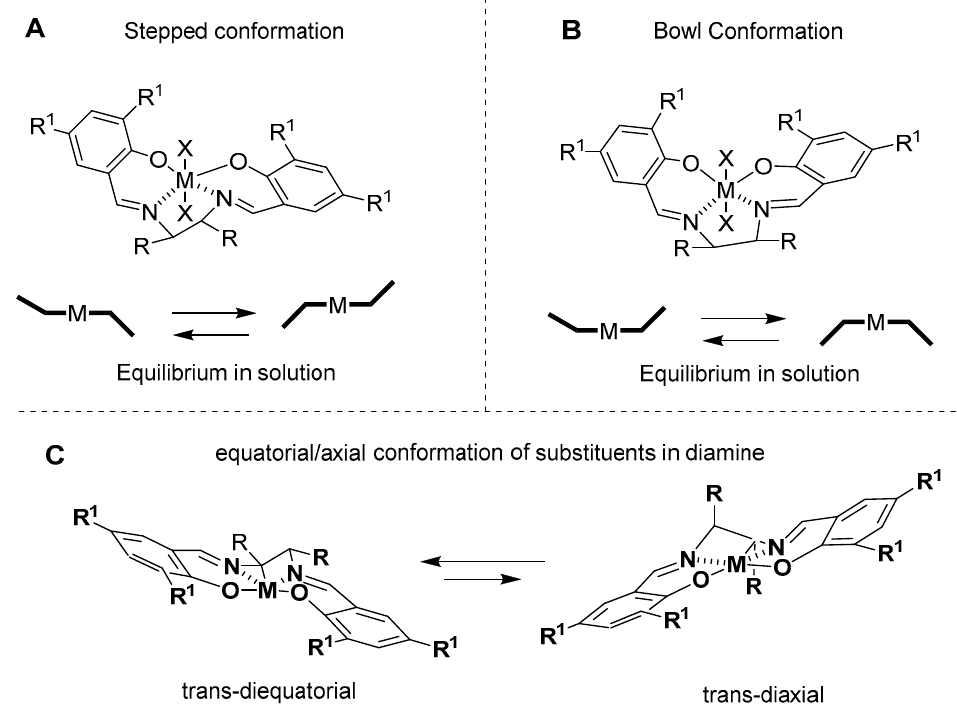
Figure 1. Possible conformations of M(salen) complexes.